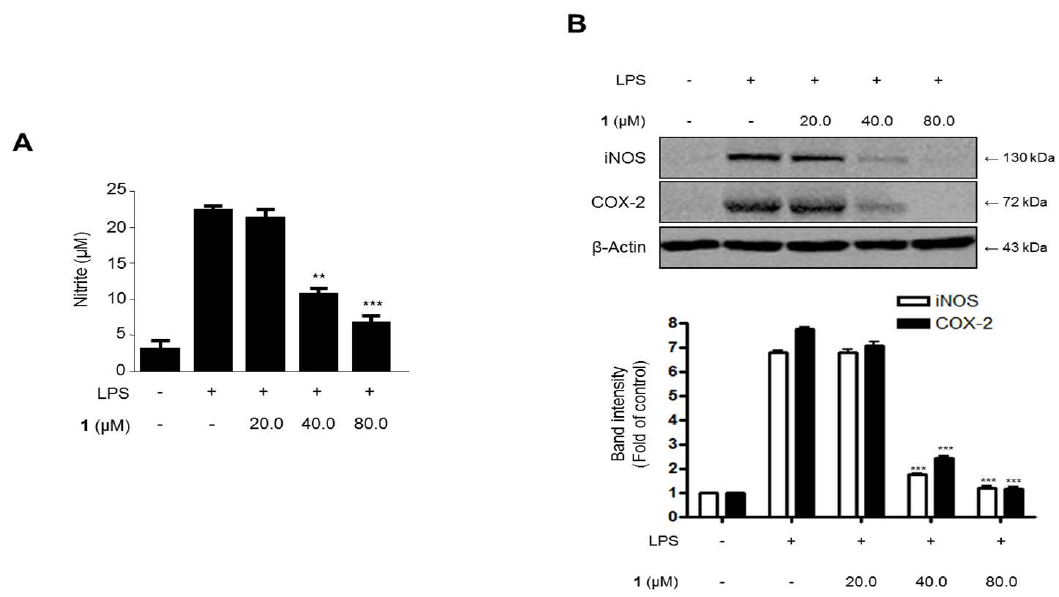
Figure 7. The effects of steppogenin ( 1 ) on nitrite ( A ) production and iNOS and COX-2 expression ( B ) in lipopolysaccharide (LPS)-stimulated primary rat microglial cells. ( A , B ) The cells were pretreated for 3 h with the indicated concentrations of 1 and then stimulated for 24 h with LPS (1 μg/mL). The data are presented as the mean ± SD of three experiments. The band intensities were quantified by densitometry and normalized to the intensities of the β-actin band; the normalized values are presented below each band. ** p < 0.01; *** p < 0.001 compared with the LPS-treated group.